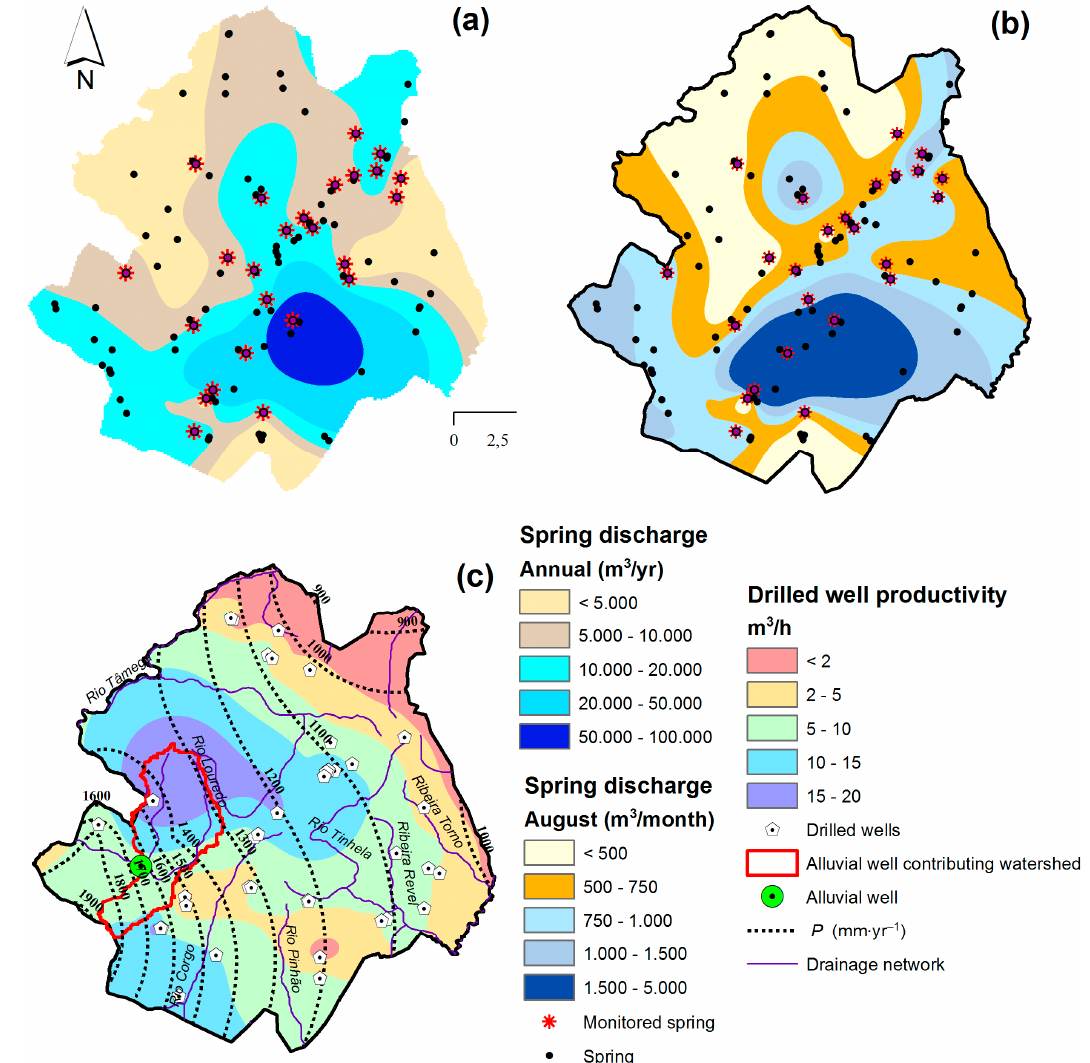
Figure 4. ( a ) Spatial distribution annual spring discharge. The shaded areas were drawn (interpolated) on the basis of discharges measured at the monitored springs. The discharge at the other springs (black circles) was estimated through digital sampling of interpolated discharges at the spring site. ( b ) Spatial distribution of August’s spring discharge. This is the month when discharges are lowest. ( c ) Spatial distribution of drilled well productivity, with indication of